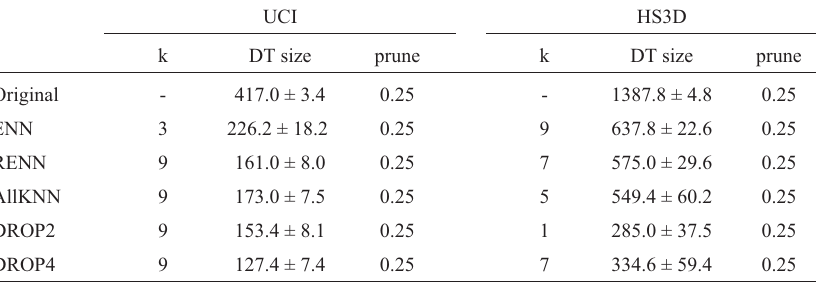
Table 6 - Mean size of DTs, best pruning and pre-processing